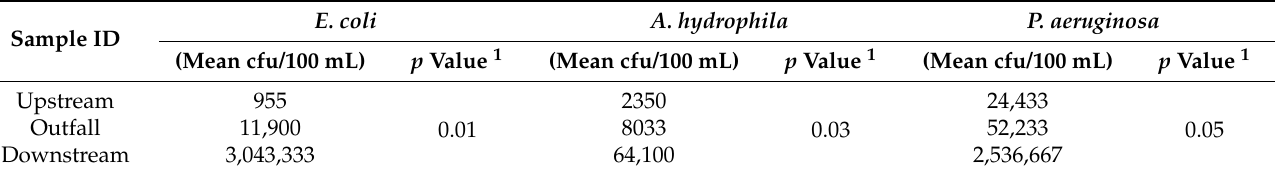
Table 4. Bacterial loads in upstream, sewage outfall, and downstream water samples collected from the Onyasia stream, Accra, Ghana (January to June 2018). Sample